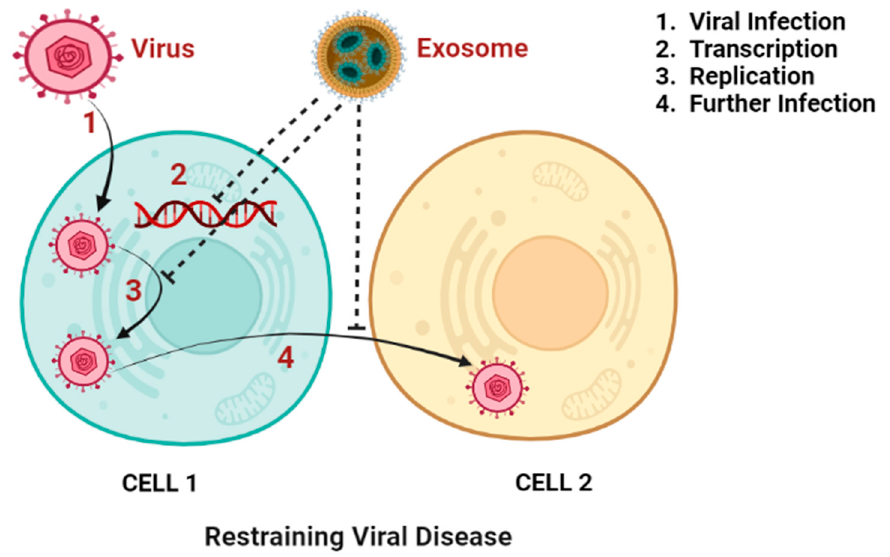
Figure 2. Depiction of the role of exosomes in restraining viral disease by suppressing viral infec- tion, transcription, replication, and further infection. (Created with Biorender.com (accessed on 28 September 2022)).